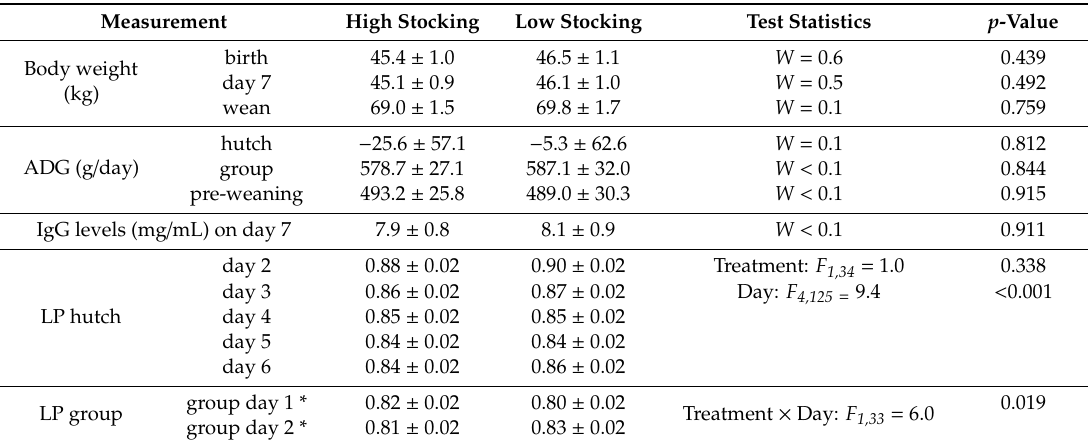
Table 2. Body weights (kg) at birth, at introduction to the group and weaning, average daily gains (ADG: g / day) in the hutch, the group and the pre-weaning period, IgG (Immunoglobulin G) levels, and daily lying proportion in the hutch (LP hutch) and in the group pen (LP group). The figures indicate means ±